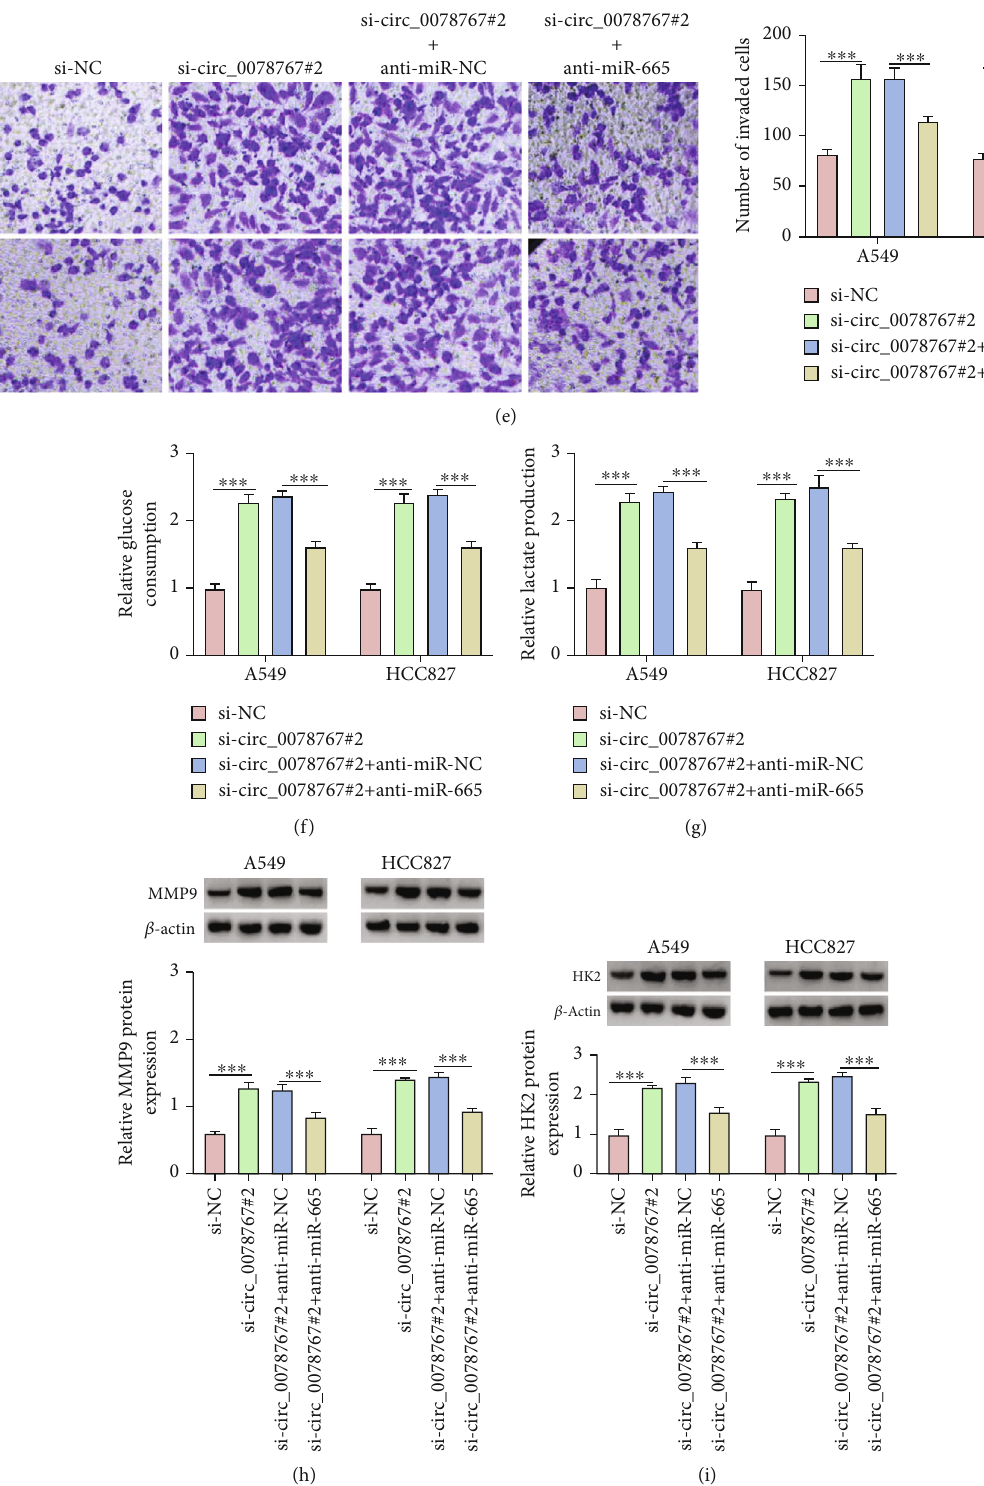
Figure 4: Circ_0078767 regulates the proliferation, migration, and invasion by targeting miR-665 in NSCLC cells. (a, b) The expression level of miR-665 was determined by qRT-PCR. (c) Colony formation assay was used to assess proliferation of transfected A549 and HCC827 cells. (g, h) Transwell assay was used to assess cell migration and invasion. (f, g) Glucose consumption and lactate production were measured to assess glycolysis metabolism using commercial kits. (h, i) The protein expression level of MMP9 and HK2 was tested by western blot analysis. ∗∗∗ P < 0 : 001